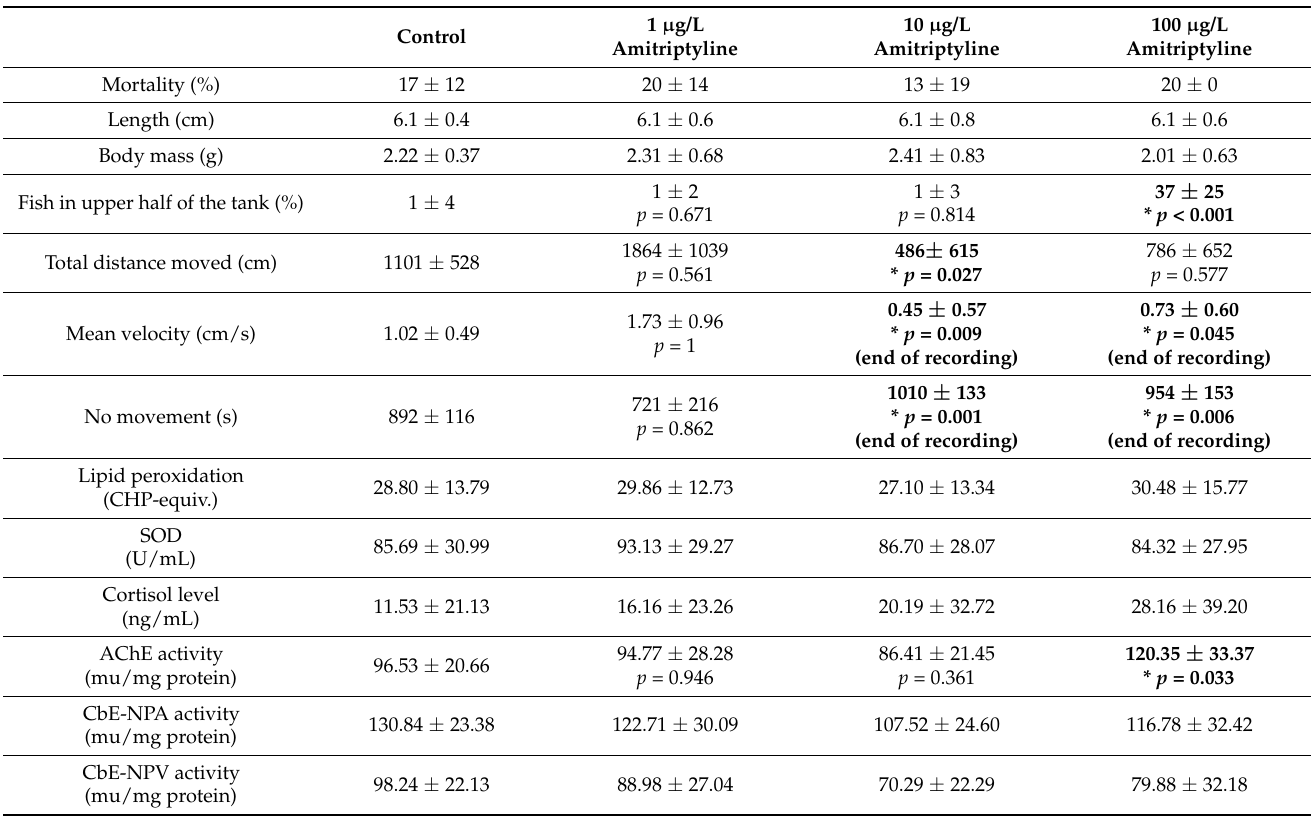
Table 3. Results of the first experiment. If significant differences occurred, p values compared to the control group are mentioned. Significant differences to the control group are indicated with an asterisk and highlighted in bold.